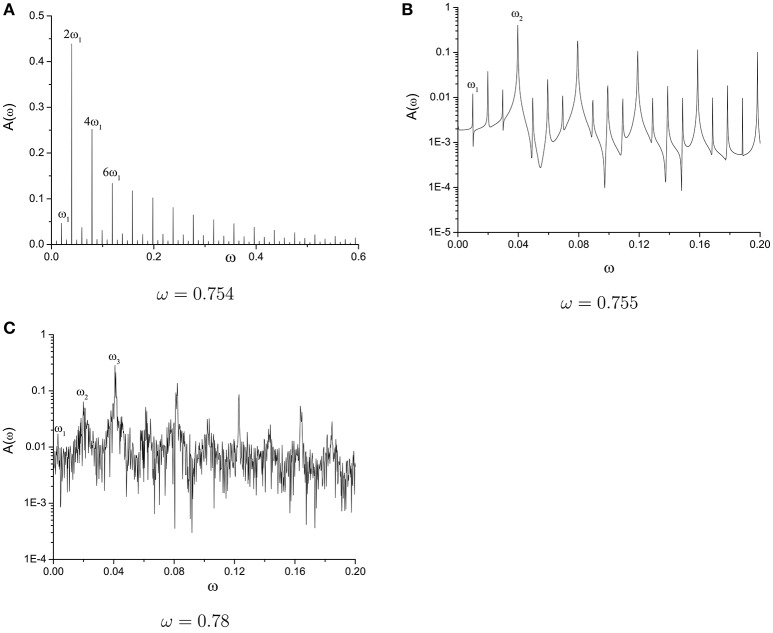
Frequency spectrum of second variable for the three different motion types. (A) ω = 0.754, (B) ω = 0.755, and (C) ω = 0.78.